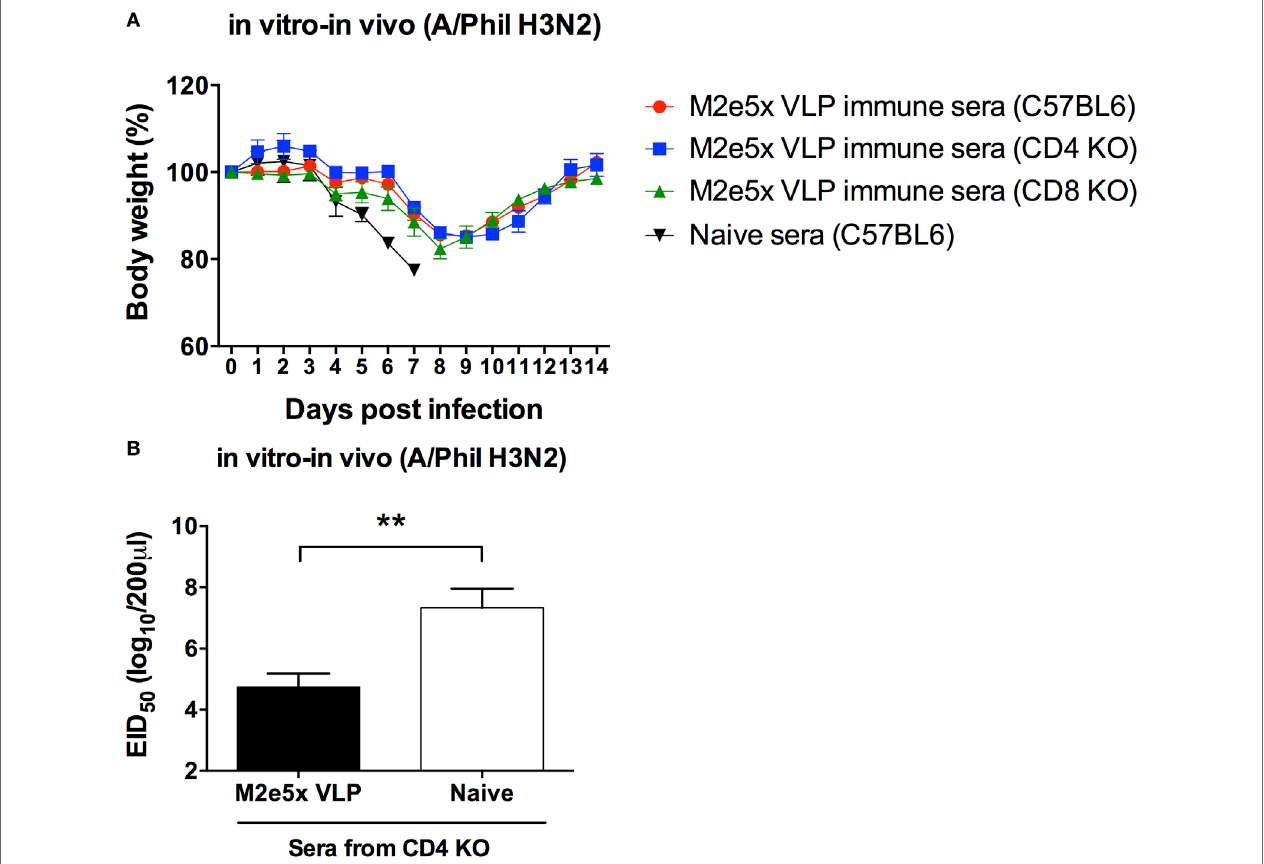
FigUre 7 | M2e antibodies in T cell-deficient mice show similar capacity to confer protection in naïve mice. Immune sera collected from immunized C57BL/6, CD4 knockout (CD4 KO), and CD8 knockout (CD8 KO) mice were incubated with influenza virus (A/Philippines/2/82 H3N2). Naive mice were intranasally infected with a mixture of a lethal dose of influenza virus and immune sera or naïve sera. Body weights were monitored for 14 days (a) . Lung viral titers day 7 post-infection was determined by the egg inoculation assay (B) . The detection limit of 50% of egg infectious dose (EID 50 ) was 1.7 Log10. Statistical significances were analyzed by 2-way ANOVA. ** p <